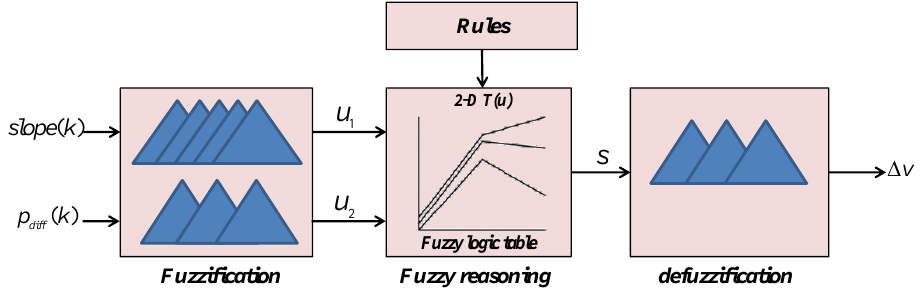
Figure 7. Structure of fuzzy logic (FL) controller.